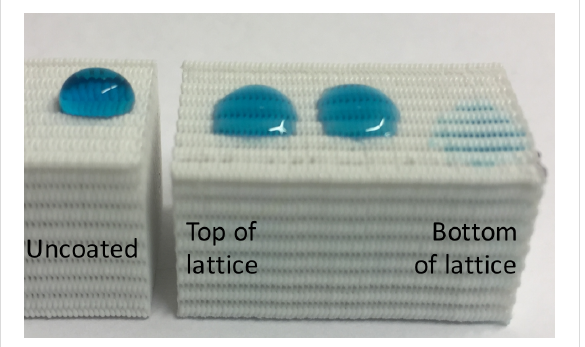
Figure 5: Water droplets (colored with blue food coloring) on an uncoated lattice and on a 25 mm tall PLA lattice coated with P(HEMA- co